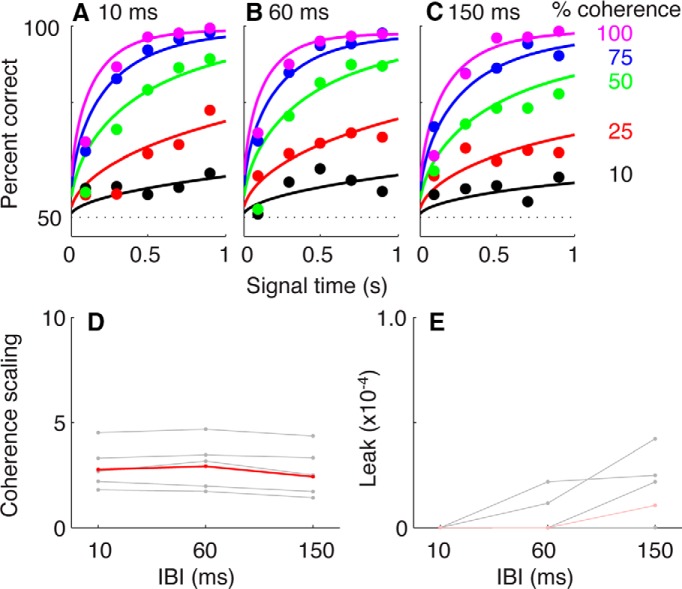
Performance on the variable-duration task. A−C, Psychometric data are plotted as a function of listening duration for different coherences and IBIs, as indicated. Each data point reflects mean performance for all five subjects as a function of coherence and signal time (plotted in 0.2 s bins, up to 1.0 s, but fit using unbinned data). The solid curves are fits from the best-fitting model with two parameters: drift rate and accumulation leak. D, E, Best-fitting values of drift rate (D) and accumulation leak (E) plotted as a function of IBI for fits to data from individual subjects (black) or combined across all subjects (red). Dark lines and symbols indicate that the model fits were improved significantly by fitting the given parameter separately for each IBI condition (likelihood-ratio test, p < 0.01q, Bonferroni-corrected for two parameters). Shaded lines and symbols indicate that the model fits were not improved significantly.